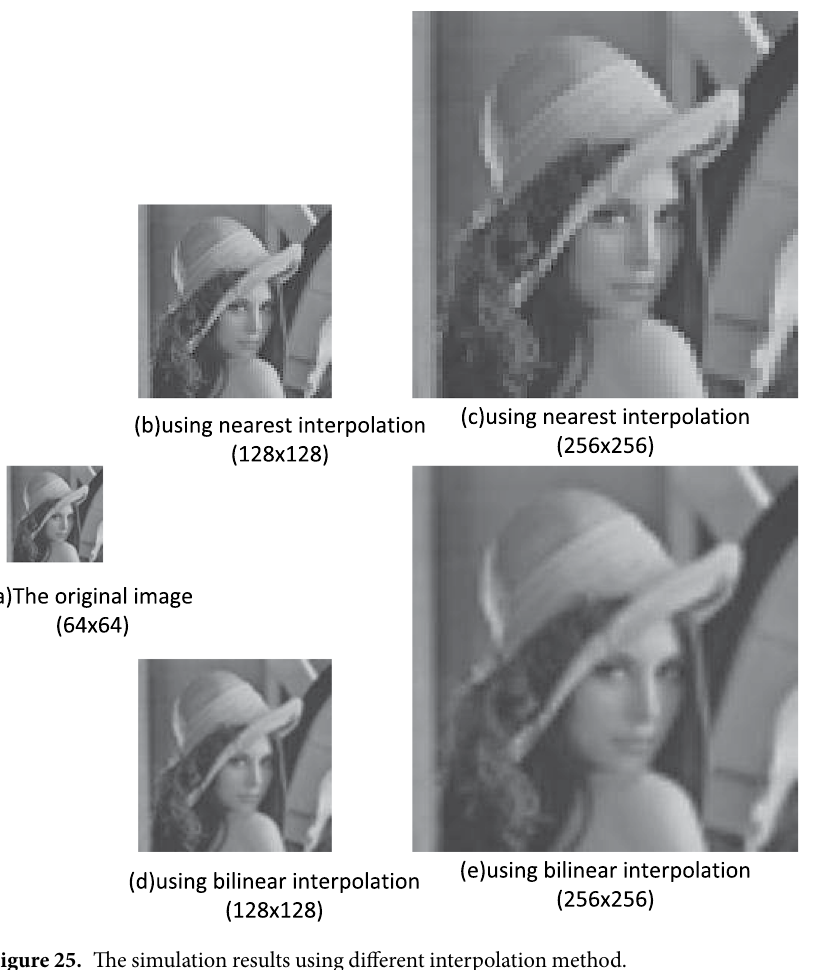
Figure 25. The simulation results using different interpolation method.